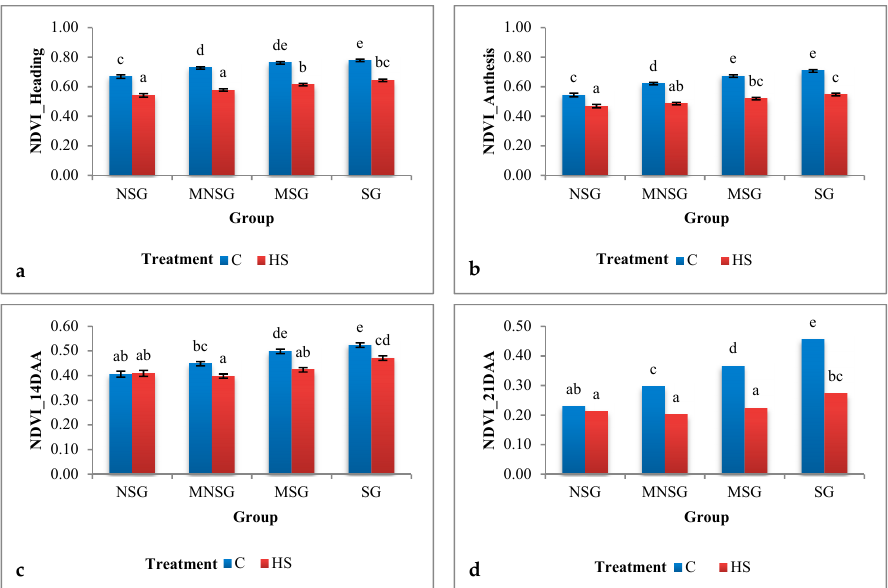
Figure 3. Variation in the normalized difference vegetative index (NDVI) between the non-stay-green (NSG), moderately non-stay-green (MNSG), moderately stay-green (MSG), and stay-green (SG) groups under control (C) and heat stress (HS) conditions. ( a ) NDVI at heading; ( b ) NDVI at anthesis; ( c ) NDVI after 14 days of anthesis; and ( d ) NDVI after 21 days of anthesis. Bars represent the least square means. Error bars correspond to the standard errors and the different lowercase letters signify the significant differences among the types and treatments at p < 0.05.